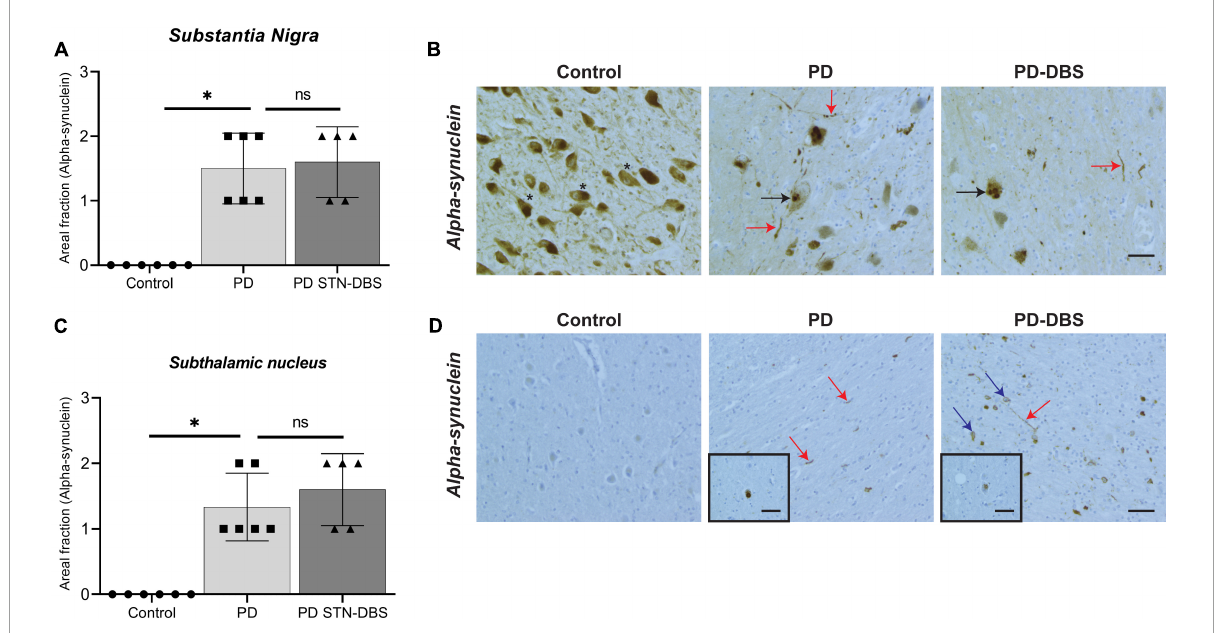
FIGURE3 Quantitation of alpha-synuclein pathology in the substantia nigra (SN) and subthalamic nucleus (STN) of control, Parkinson’s disease (PD) and PD STN-DBS cases. (A) No alpha-synuclein pathology was seen in the SN control cases. Alpha-synuclein pathology was significantly higher in PD ( p = 0.008) and STN-DBS cases ( p = 0.007). No changes in alpha-synuclein expression were seen in the SN in PD and STN-DBS patients ( p = 1.000). (B) Asterisks indicate pigmented neurons in the SN. Both Lewy bodies (black arrows) and Lewy neurites (red arrows) were observed in the SN PD and Deep brain stimulation (DBS) cases. (C) In the control cases, no alpha-synuclein was present in the STN. Alpha-synuclein aggregates were significantly higher in PD ( p = 0.013) and STN-DBS ( p = 0.004) compared to controls with no differences between PD and STN-DBS cases ( p = 1.000). (D) Lewy neurites (red arrows) and Lewy bodies (blue arrows) were observed in the STN in all PD cases (inserts in D). Occasional Lewy bodies and alpha-synuclein positive neurons were also seen (D inserts). All values are expressed as mean ± SEM. Scale bar = 50